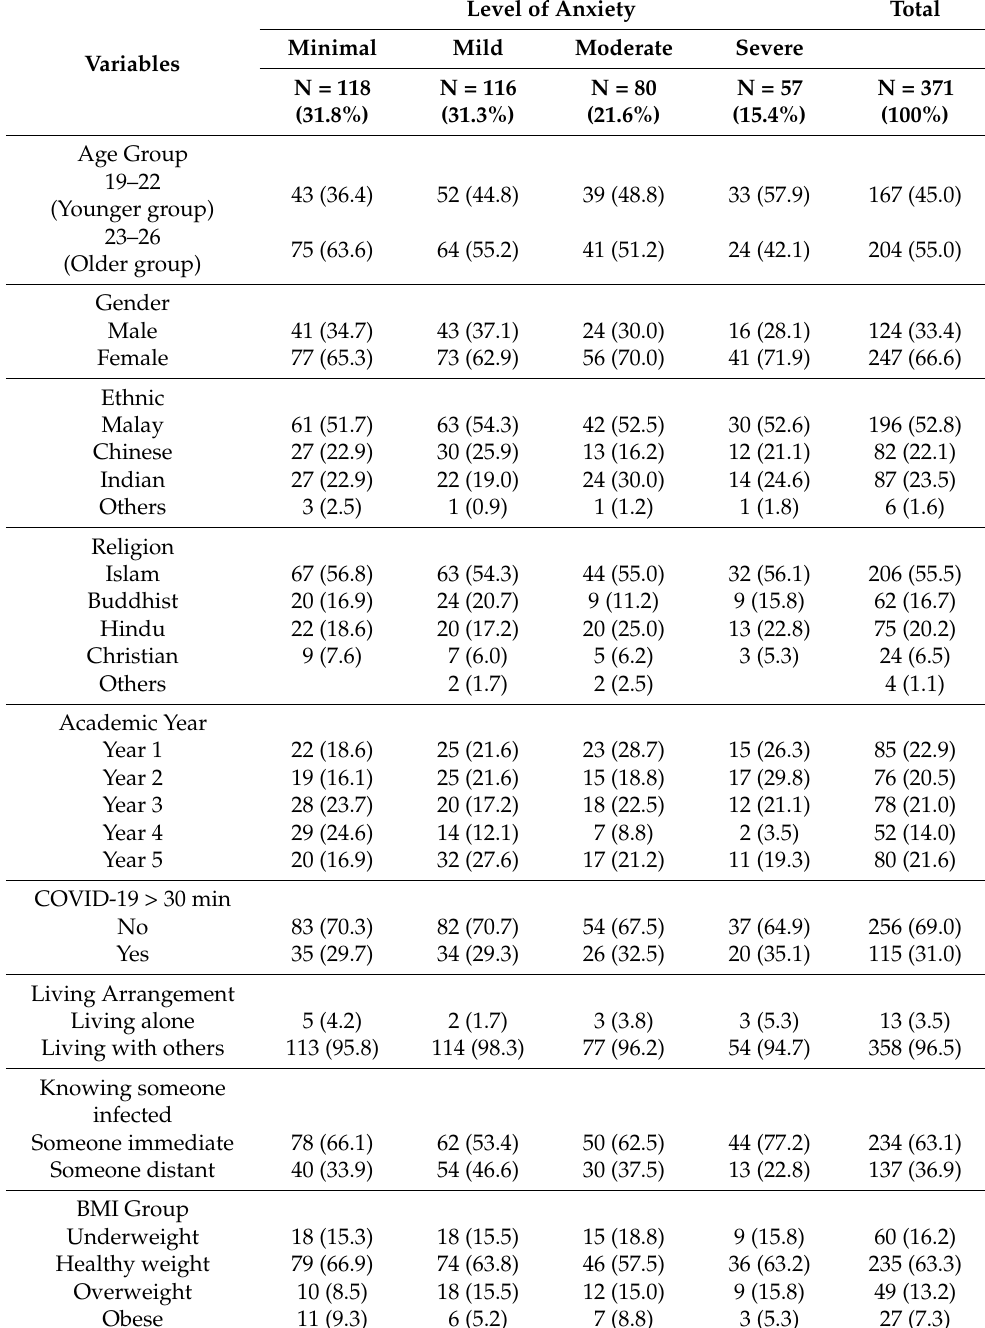
Table 1. Sociodemographic Factors and Level of Anxiety among medical